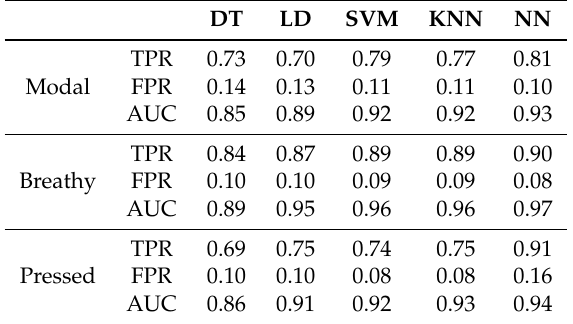
Figure 7. Per-type classification accuracies for the full set and the LOFO subsets. The red dashed line represents an averaged accuracy on a data-set as a function of the classifier. ( a ) Modal voice classification, ( b ) breathy voice classification and ( c ) pressed voice classification. Table 3. True Positive Rate (TPR), False Positive Rate (FPR) and Area Under the receiver operating characteristic Curve (AUC) of different classifiers for different voice types based on the full feature